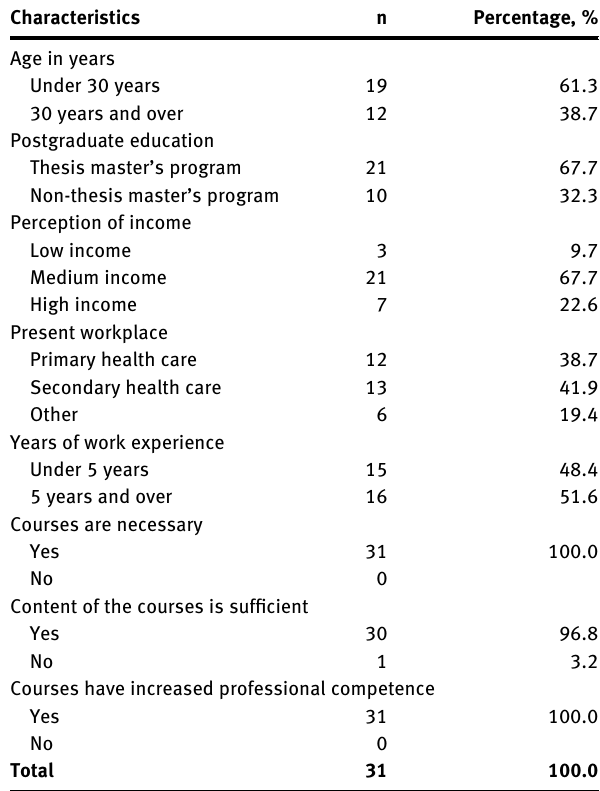
Table  : Descriptive characteristics of postgraduate midwifery